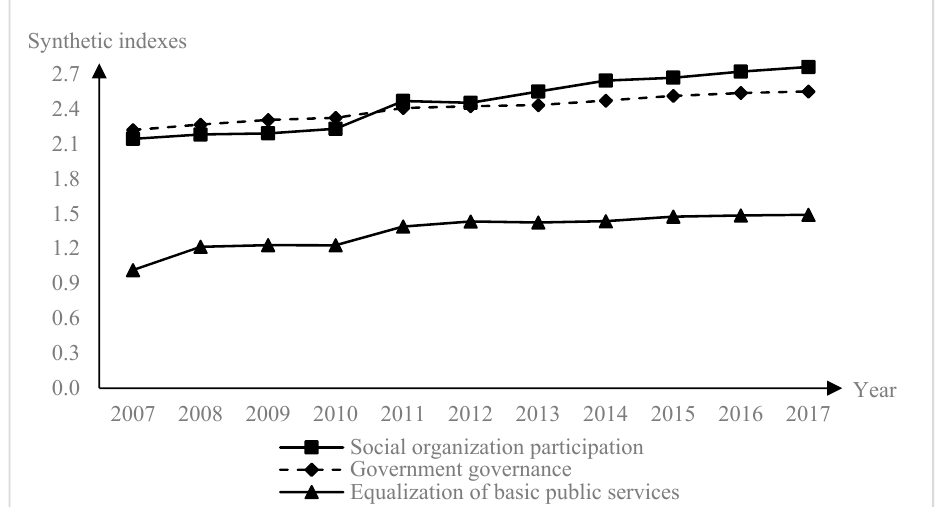
Figure 3. The synthetic index of variables.